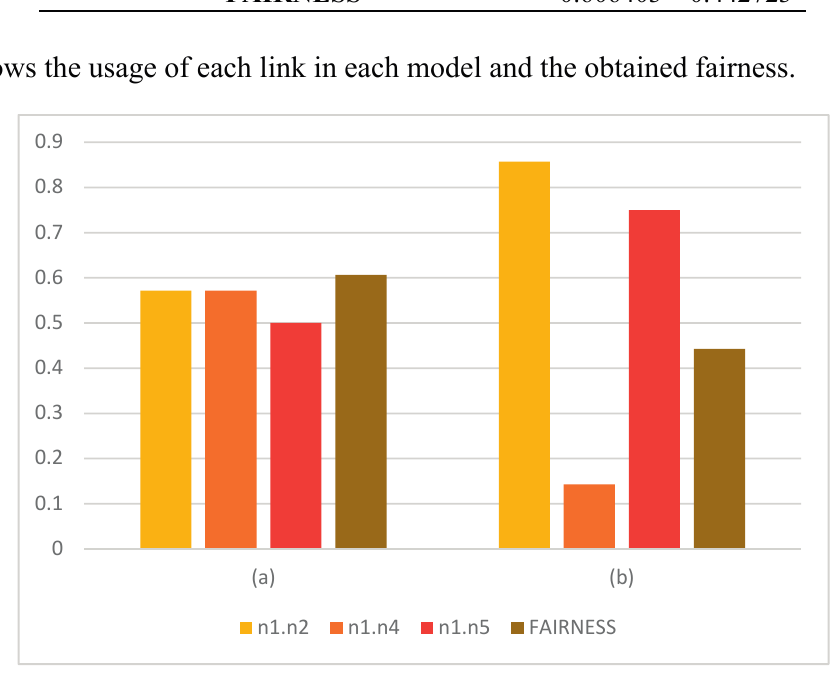
Figure 11. Graphical results in congestion level.